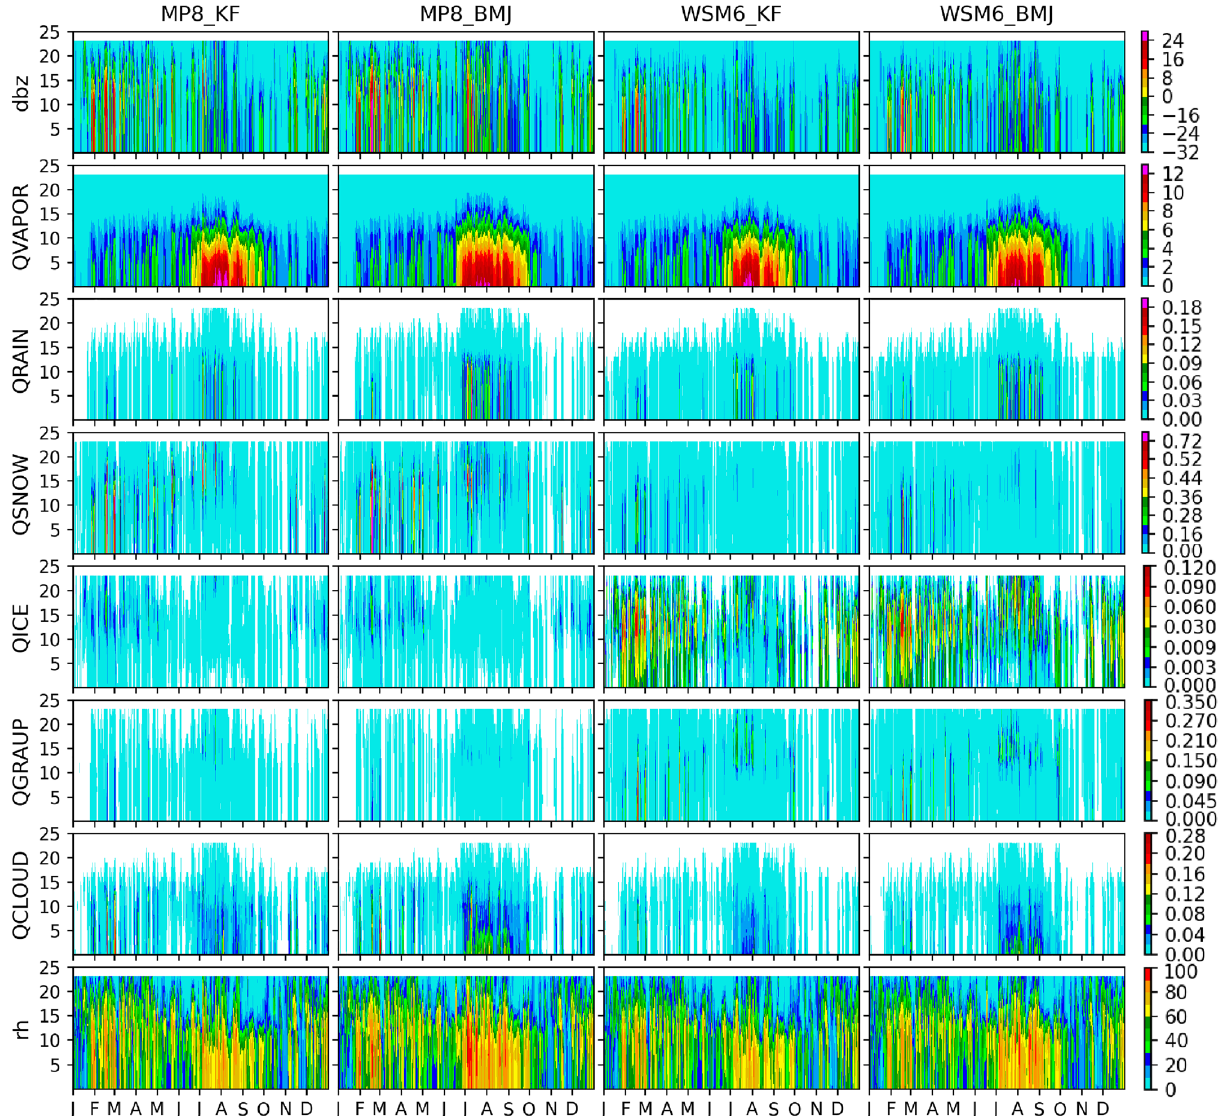
Figure 12. Area-averaged mixing ratio (dbz, QVAPOR, QRAIN, QICE, QGRAUP, and QCLOUD) over d03. Mixing ratios are shown as they varying over model levels with time for MP8_KF, MP8_BMJ, WSM6_KF, and WSM6_BMJ. The unit of mixing ratio is